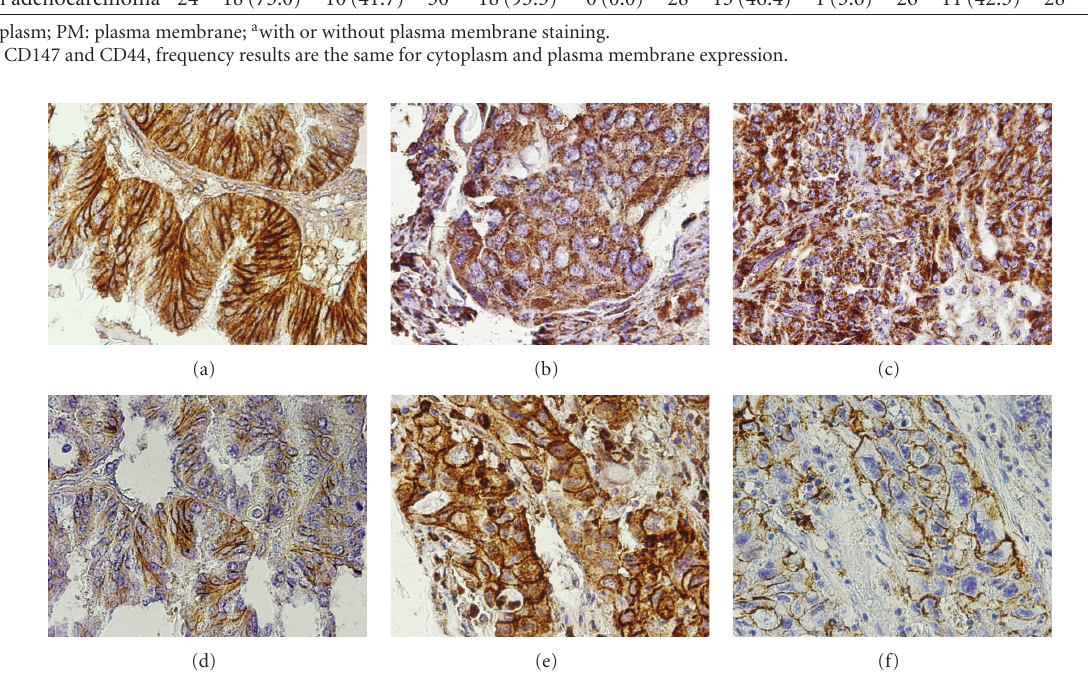
Figure 2: Representative immunohistochemical expression of MCT1 in ovarian carcinoma (a), MCT2 in breast carcinoma (b), MCT4 in ovarian carcinoma (c), CD147 in ovarian carcinoma (d), MCT1 in lung cancer (e), and CD44 in lung cancer (f). Plasma membrane staining for both MCT1 (a) and CD147 (d) is shown in the same tumour area of an ovary cancer case and for both MCT1 (e) and CD44 (f) in the same area of lung cancer